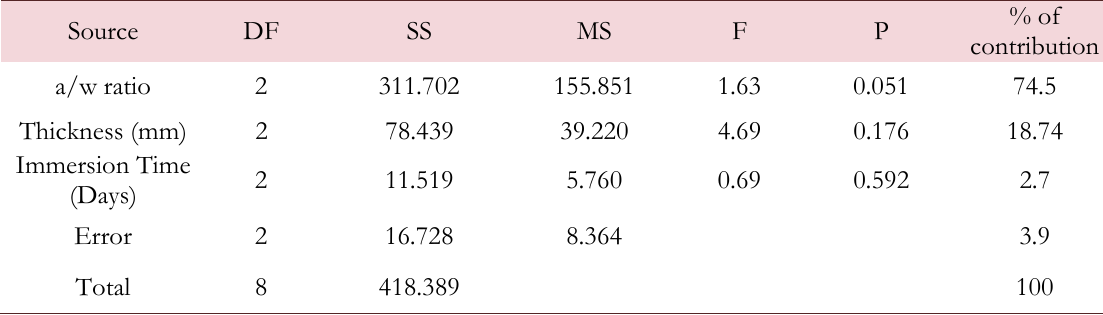
Table 3: ANOVA for load carrying capacity